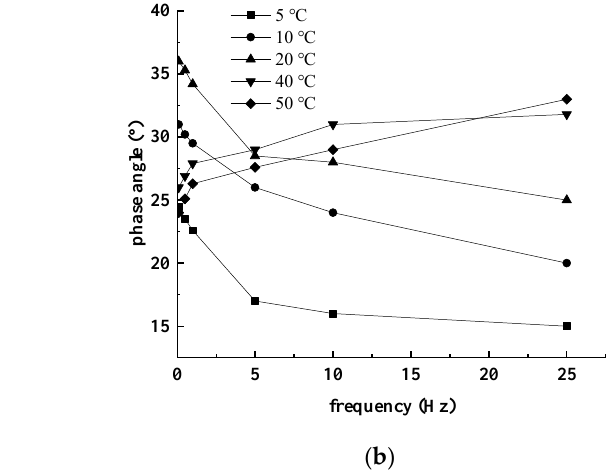
Figure 12. The relationship between the phase angle and loading frequency: ( a ) rubber-powder-modified asphalt mixture; ( b ) SBS-modified asphalt mixture.